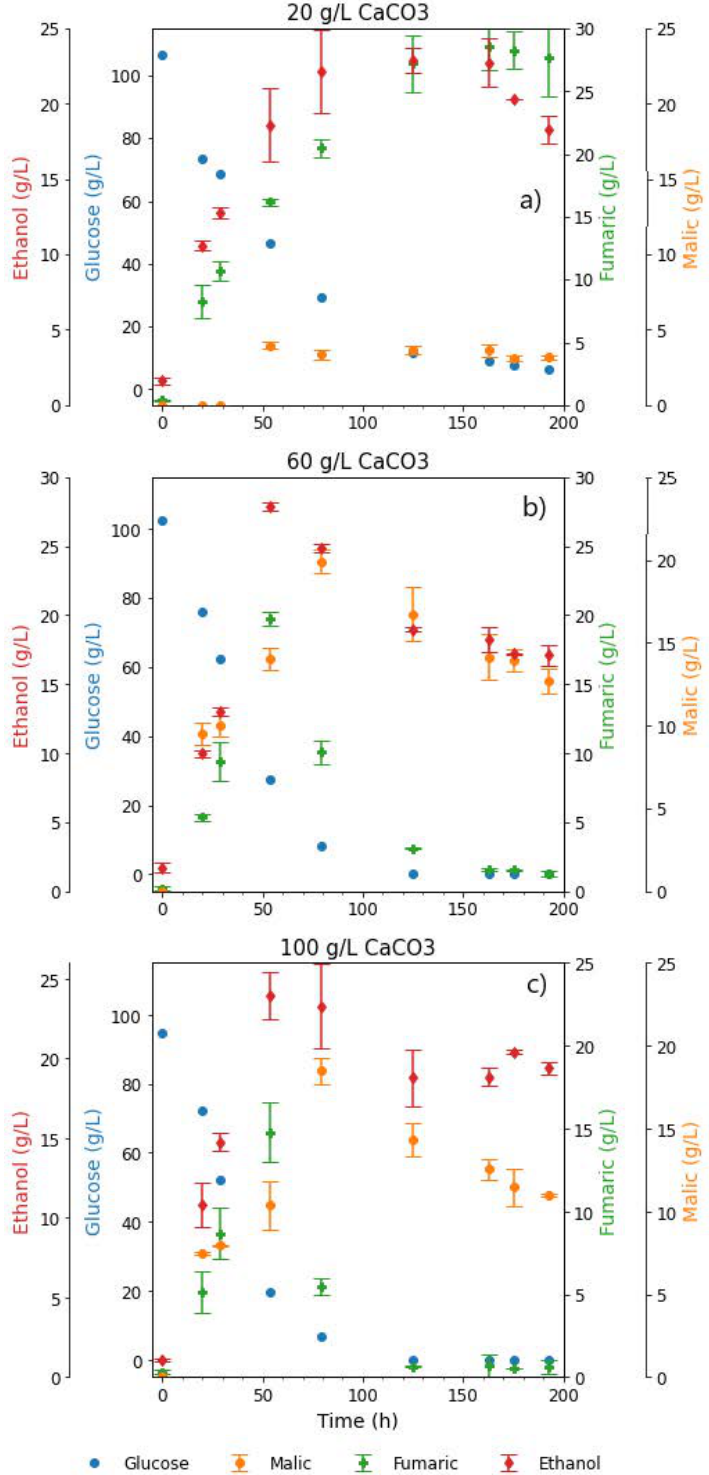
Figure 2. Extracellular concentrations of glucose and metabolites during shake flask cultivation of R. delemar on 100gL − 1 glucose, in the presence of ( a ) 20gL − 1 CaCO 3 , ( b ) 60gL − 1 CaCO 3 , and ( c ) 100gL − 1 CaCO 3 . Cultures were incubated at 34 °C and 200 RPM. Results are the mean of triplicate experiments and error bars indicate the standard deviation.